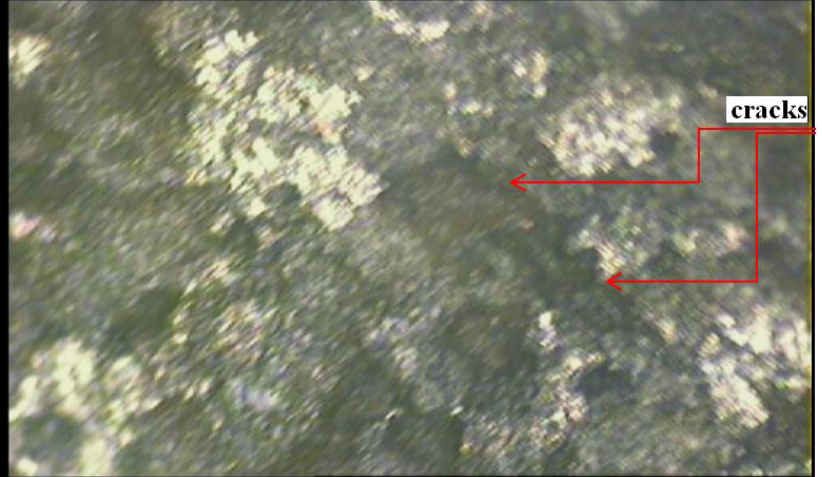
Fig.5: Thermal treated at 1150 (cid:1320) , microscopic structure of cermet coat after laser